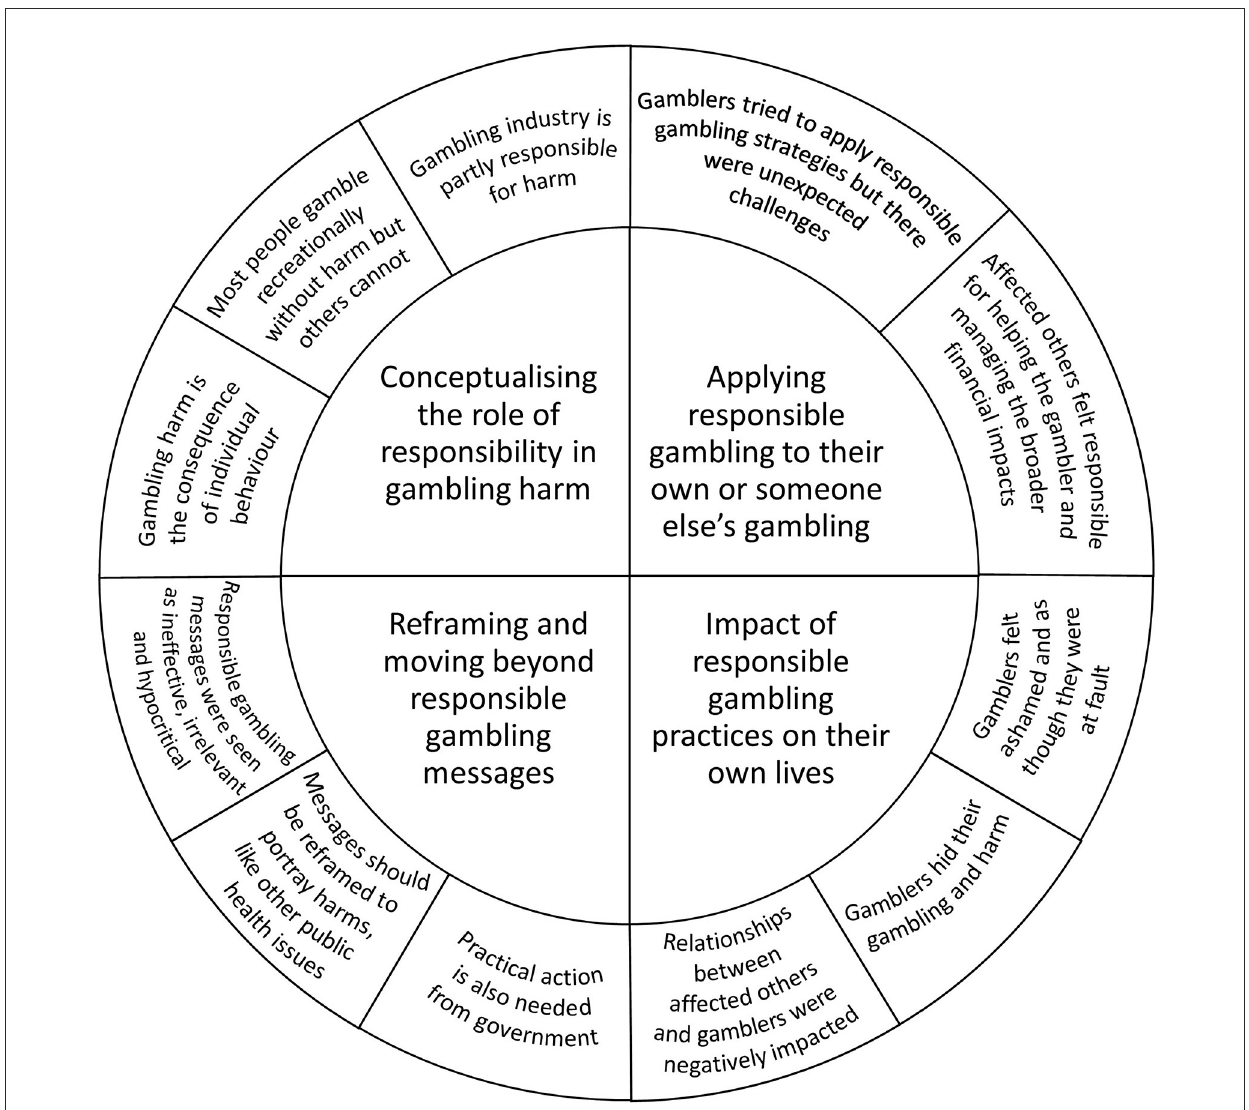
FIGURE1 Understanding how gamblers and affected others conceptualize and apply personal responsibility and the impact this has in their